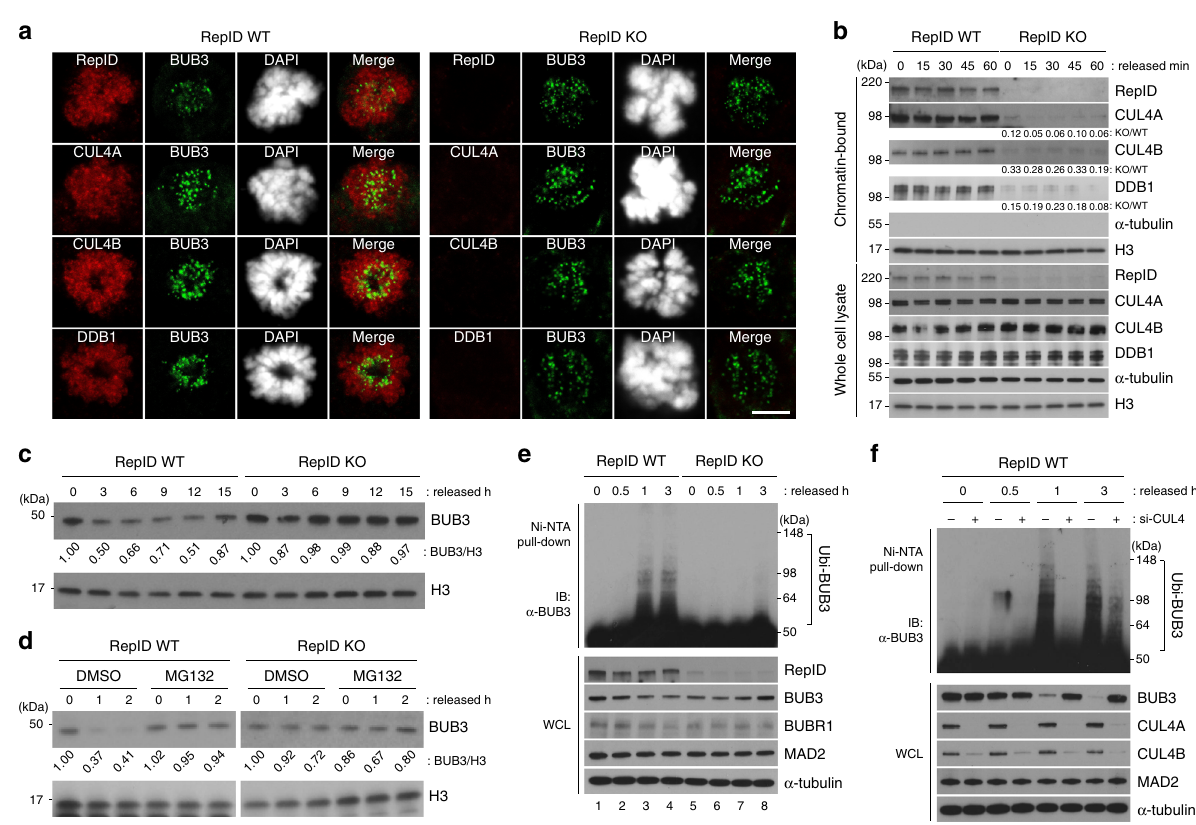
Fig. 3 RepID-CRL4 ubiquitinates BUB3 during mitosis. a RepID-CRL4 localizes with BUB3 at the kinetochore in prometaphase cells. Immuno fl uorescence analysis of HCT116 RepID WT and KO cells was carried out in methanol- fi xed cells using antibodies directed against CRL4 components (RepID, CUL4A, CUL4B, or DDB1; red signals) and BUB3 (green signal). CRL4 components do not associate with chromatin in the RepID KO cells because RepID, which recruits CRL4 to chromatin, is absent. Scale bar: 10 μ m. b RepID-dependent CRL4 recruitment to chromatin throughout the cell cycle. Mitotic HCT116 RepID WT or KO cells were collected after a nocodazole block, reseeded in drug-free medium, harvested at the indicated time points, and chromatin-bound proteins were analyzed by immunoblotting and densitometry. Histone H3 and α -Tubulin were used as a loading control. c , d BUB3 is degraded in mitosis in RepID-expressing cells but not in RepID-de fi cient cells. HCT116 RepID WT or KO cells were released from mitotic block for the indicated time periods with or without the proteasome inhibitor MG132. Cell lysates were subjected to immunoblot analysis and densitometry. e BUB3 is ubiquitinated during mitosis in RepID-expressing cells but not in RepID-de fi cient cells. HIS-tagged ubiquitin plasmids were transiently transfected into HCT116 RepID WT and KO cells. Cells were collected at the indicated times after release from a nocodazole block, and his-tagged proteins from the released cells were isolated on Ni-NTA beads followed by immunoblot analysis. f Knockdown of CUL4 prevented the ubiquitination of BUB3 in RepID-expressing cells. HIS-ubiquitin plasmid and siRNA-CUL4 (directed against both CUL4A and CUL4B) were co-transfected into HCT116 RepID WT cells, which were synchronized, released, lysed, isolated with Ni-NTA beads, and analyzed for the presence of ubiquitinated BUB3 by immunoblotting as in e